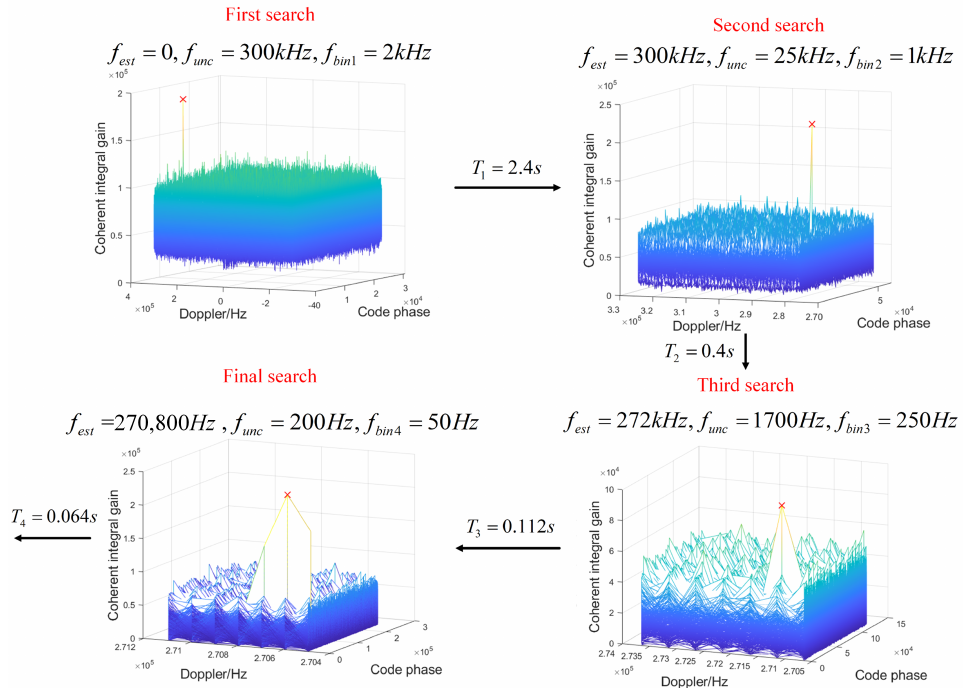
Figure 10. ILS simulation results (the variation of Doppler and code phase information obtained through four iterative